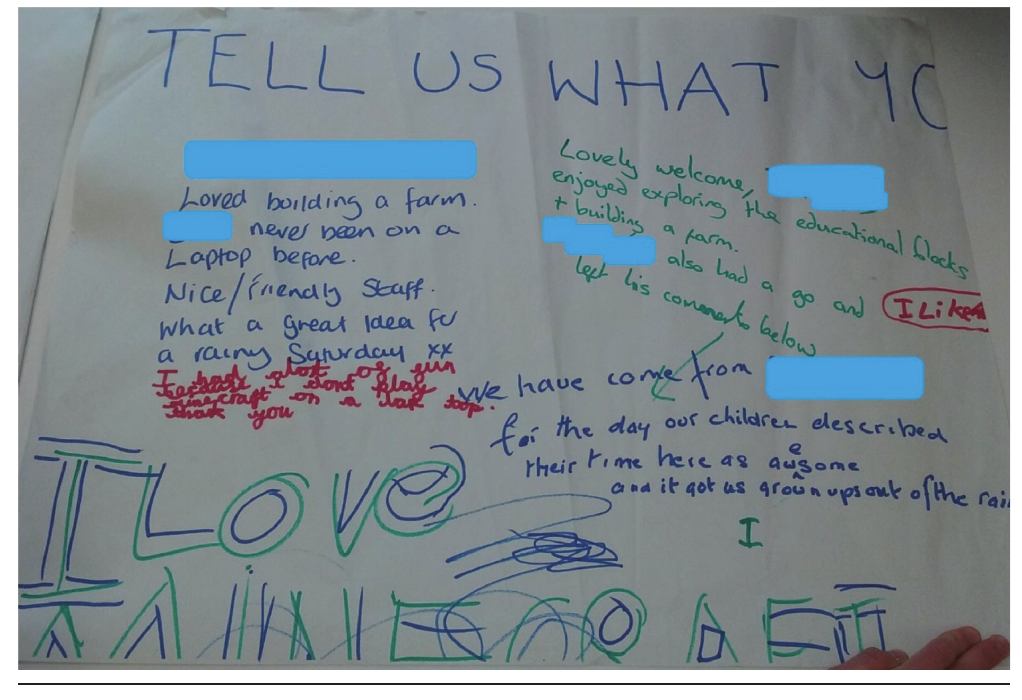
Figure 4: A portion of the ‘word wall’ feedback left at Lancaster Library in 2015 (some identifying details have been redacted for privacy)